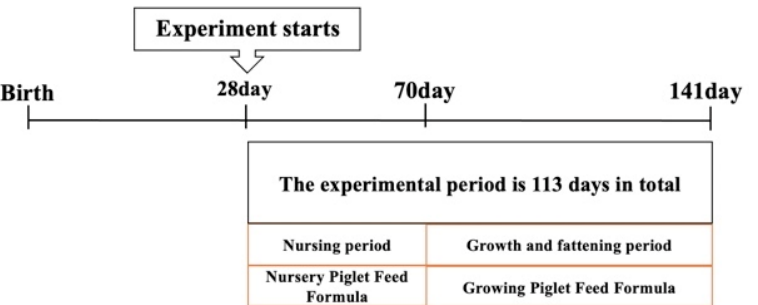
Figure 1. Schematic diagram of the experimental cycle.